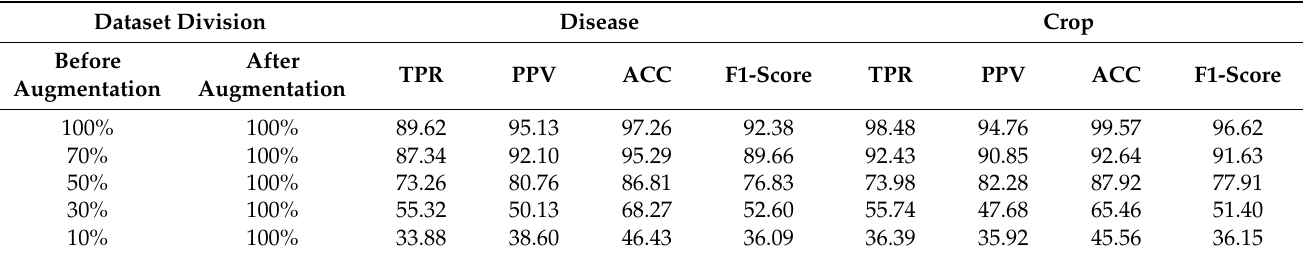
Table 28. Comparison of accuracies achieved by the proposed PI-CNN in the original and PI-GAN- augmented datasets. The accuracies were achieved in the PlantVillage dataset (unit: %).